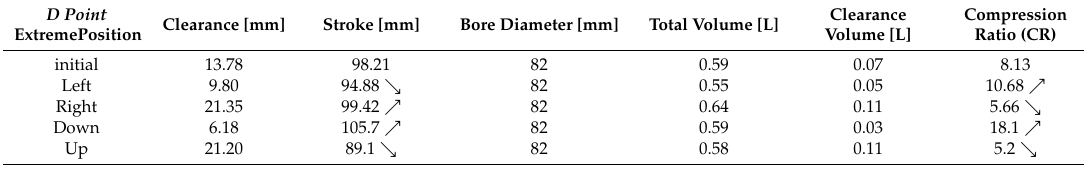
Table 2. Output kinematic parameters for extreme position of pivot point D.